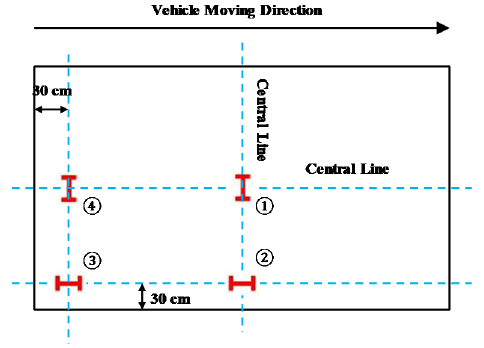
Figure 7. Instrumentation layout.